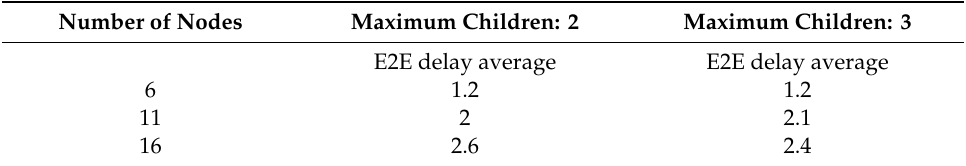
Table 4. E2E delay average